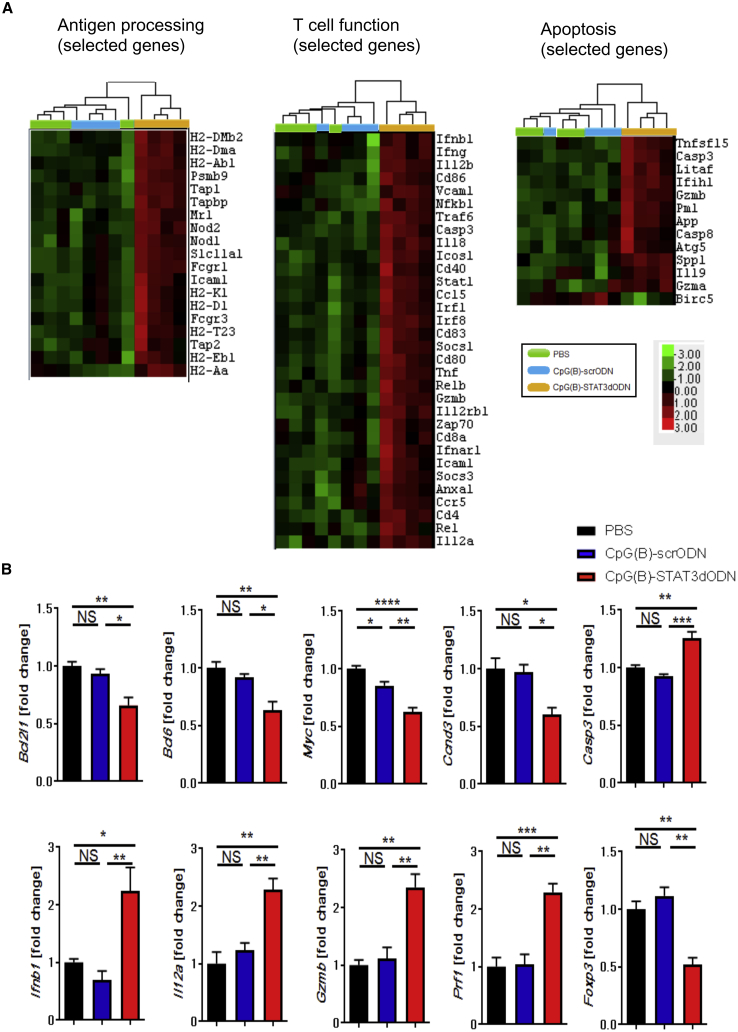
Gene Expression Profiling of BCL following TLR9 Stimulation with or without Concurrent STAT3 InhibitionMice with s.c.-established A20 lymphoma were treated starting on day 14 after tumor challenge using 1 mg/kg CpG(B)-STAT3dODN, control CpG(B)-scrODN, or PBS three times every other day (n = 4 per each group). Before tumor volumes differed, tumors were harvested to isolate total RNA for NanoString analysis using the mouse-specific PanCancer Immune Profiling panel. (A) Heatmap analyses for selected functional groups of genes related to antigen processing (left), T cell function (middle), and apoptosis (right). (B) Graph bars representing expression of specific targets from apoptosis- and T cell function-related groups; data indicate means ± SEM (n = 4). *p < 0.05, **p < 0.01, ***p < 0.001, ****p ≤ 0.0001; NS, not significant.